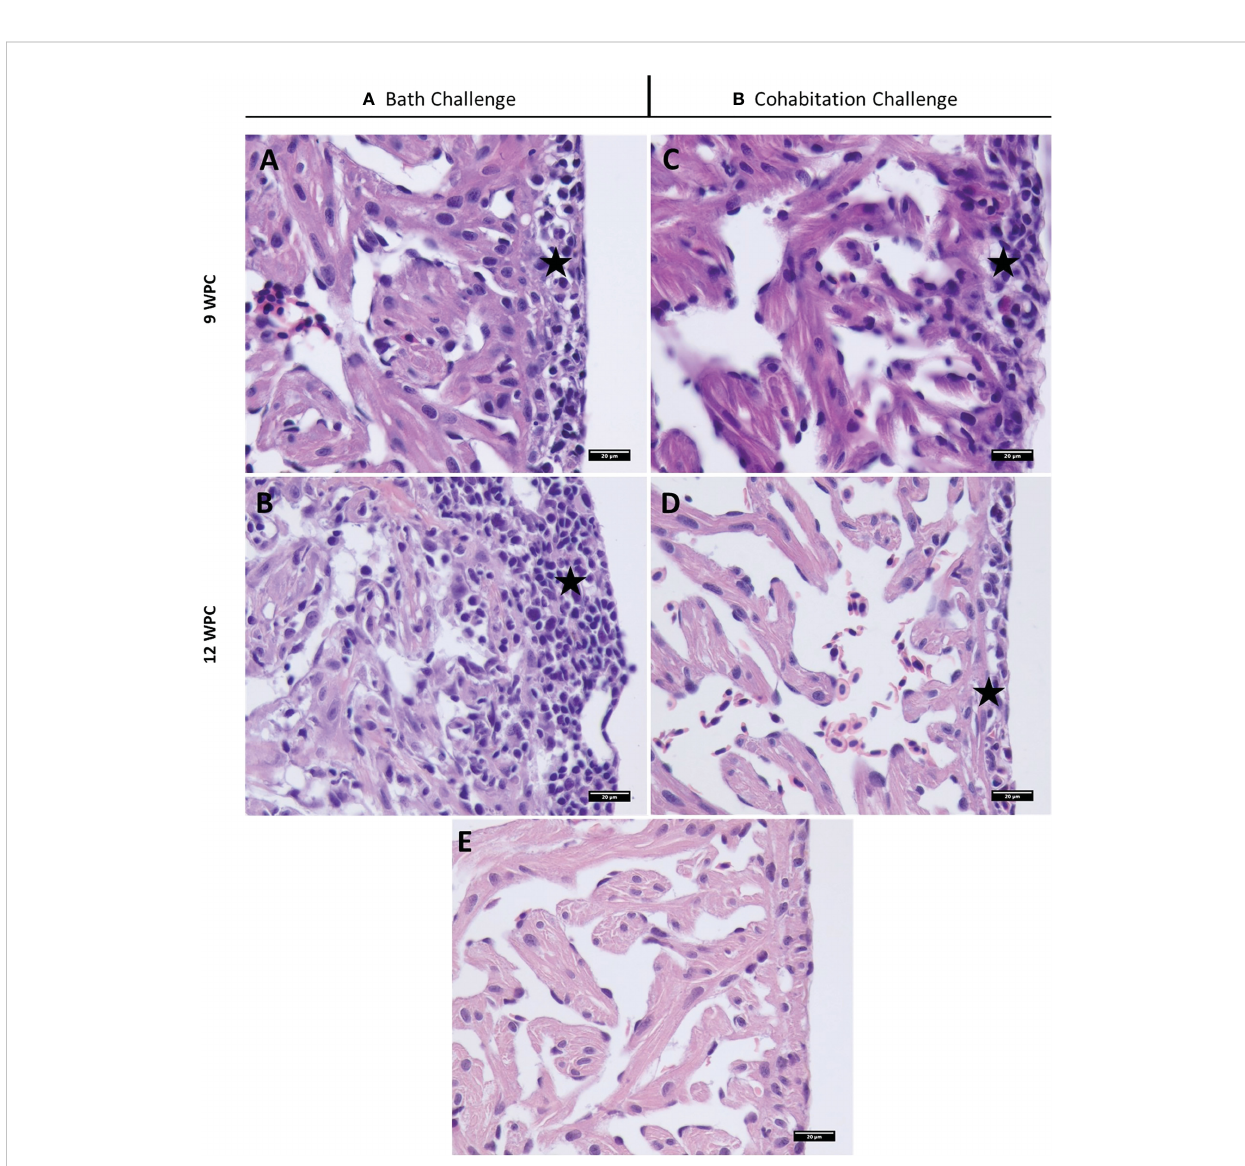
FIGURE 5 Histopathological changes in PRV-1 infected Atlantic salmon fry heart (A, B) . Bath challenged fry heart ventricle displaying epicarditis at 9 and 12 WPI and in fl ammation in myocardium typical of HSMI (C, D) . Cohabitation challenged fi sh showing mild in fl ammation mainly in epicardium at 9 and 12 WPI. (E) Noninfected control salmon heart at 12 WPC. Stars highlight epicarditis.